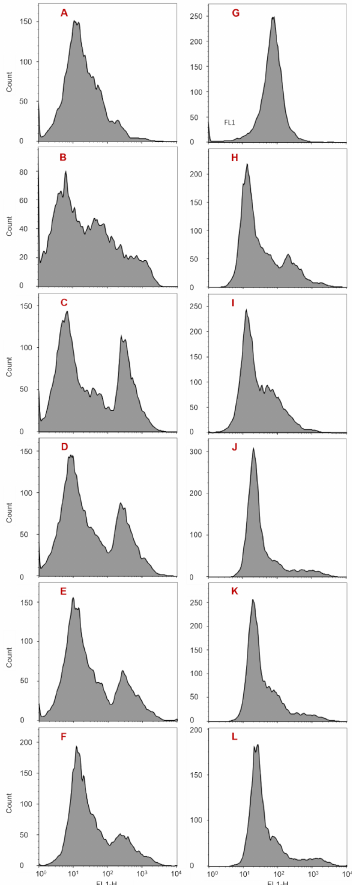
Figure 5. Cell death of residual cells within 96 h after treatment with NC or MC (SYTOX Green staining). ( A ) Normal cells measured at 3 h (group 1); ( B – F ) residual cells treated with NC measured at 3 h, 24 h, 48 h, 72 h, and 96 h, respectively (group 2); ( H – L ) residual cells treated with MC measured at 3 h, 24 h, 48 h, 72 h, and 96 h, respectively (group 3); ( G ) SYTOX Green-positive